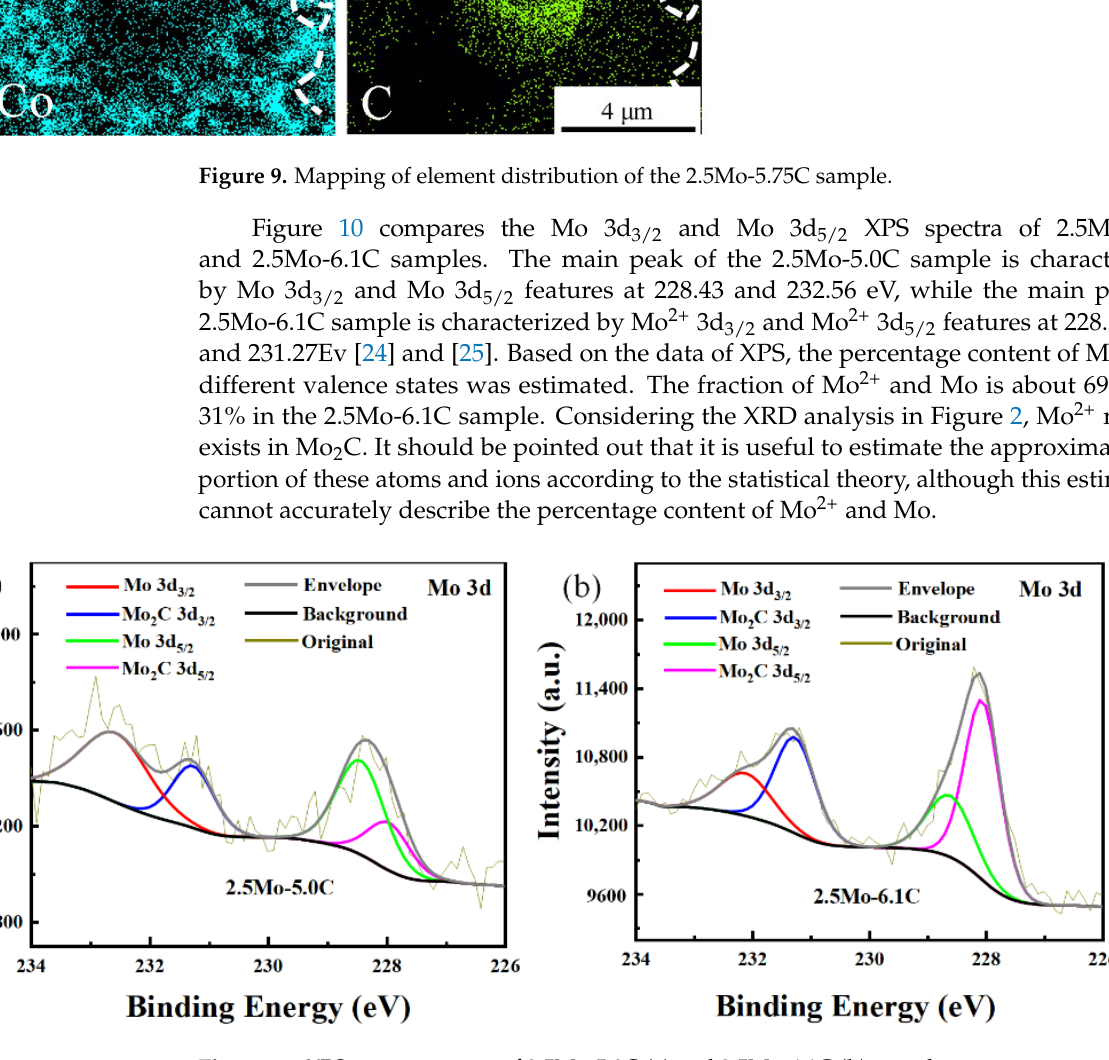
Figure 9. Mapping of element distribution of the 2.5Mo-5.75C sample.